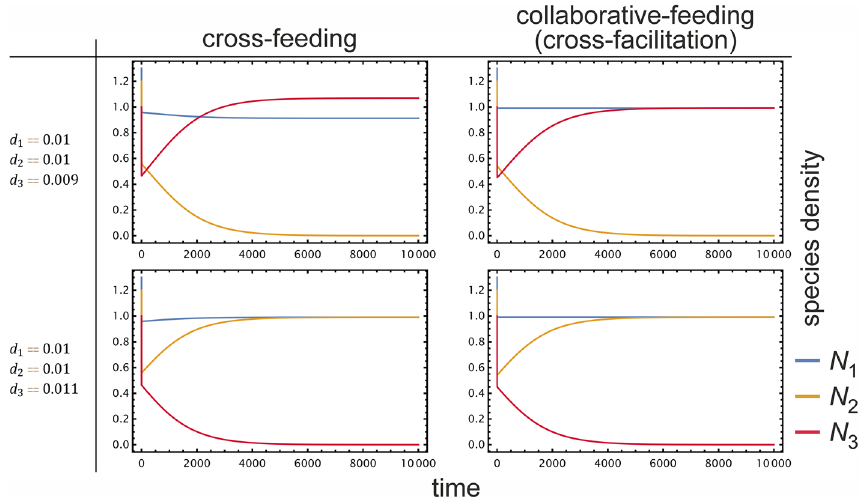
Figure 2. Time-evolution of tripartite microbial systems with cross-feeding or collaborative-feeding interactions, depending on interaction type and per-capita mortality rate ( d ). The x -axis represents time, the y -axis represents species density. In both interaction types, only two species can stably coexist, the third one being extinct in the equilibrium. Whenever the mutant species (red) has smaller mortality than its parent ( d 3 < d 2 , top row), it can invade, causing the extinction of the resident parent (yellow). If the mutant mortality is larger (bottom row), it cannot invade. Parameters are { b 1 = b 2 = b 3 = 1, r 1 = r 2 = 1, δ 1 = δ 2 = 0.1, k 1 = k 2 = k 3 = 0.1, c 1 = c 2 = c 3 = 1, d 1 = d 2 =